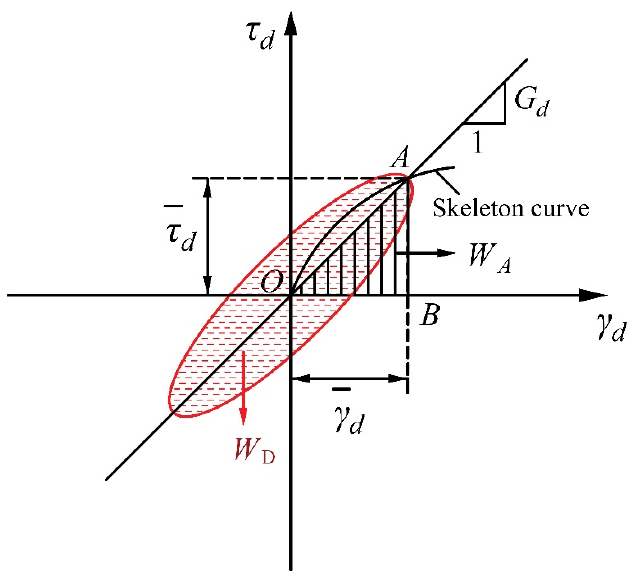
Figure 5. Determination of dynamic shear modulus and damping ratio of a sand–rubber mixture.